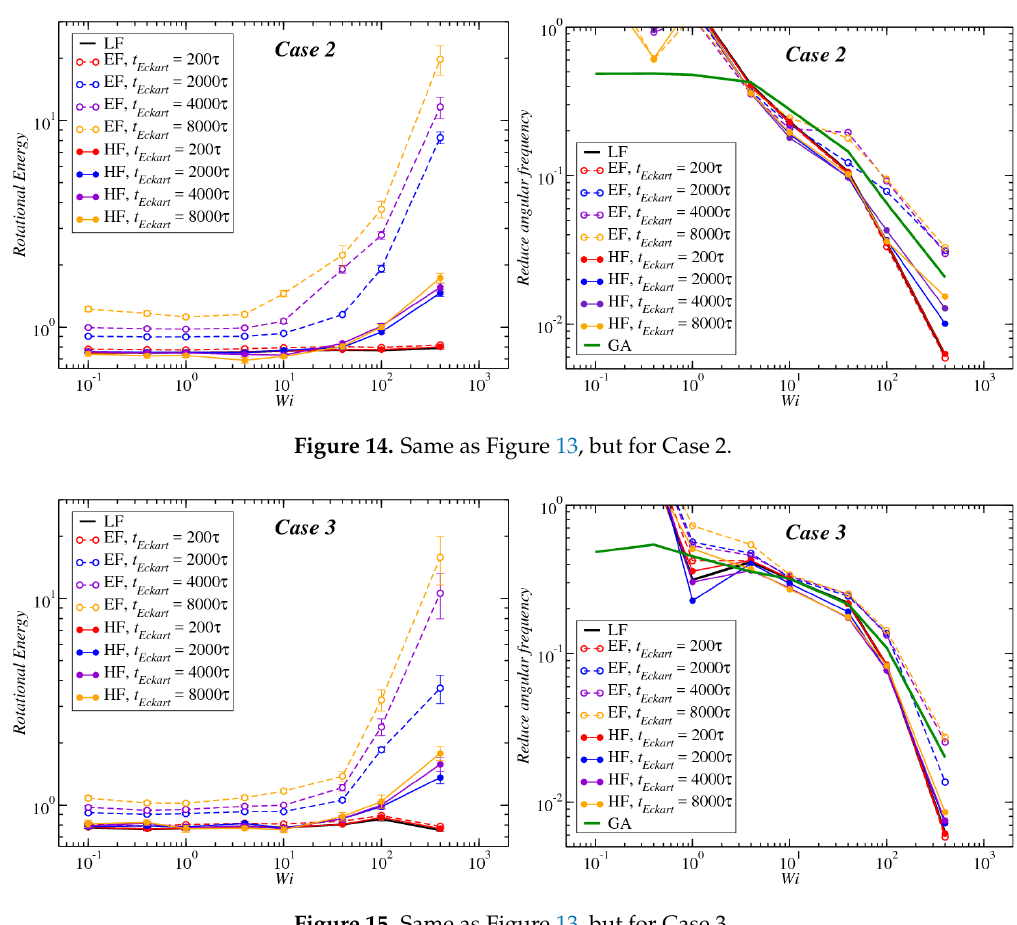
Figure 15. Same as Figure 13, but for Case